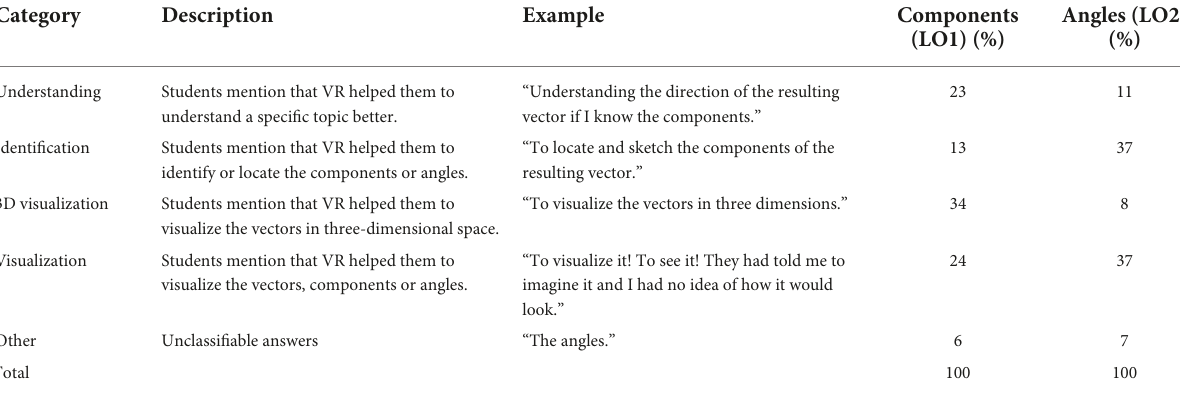
TABLE 4 Description of categories for questions LO1 and LO2.